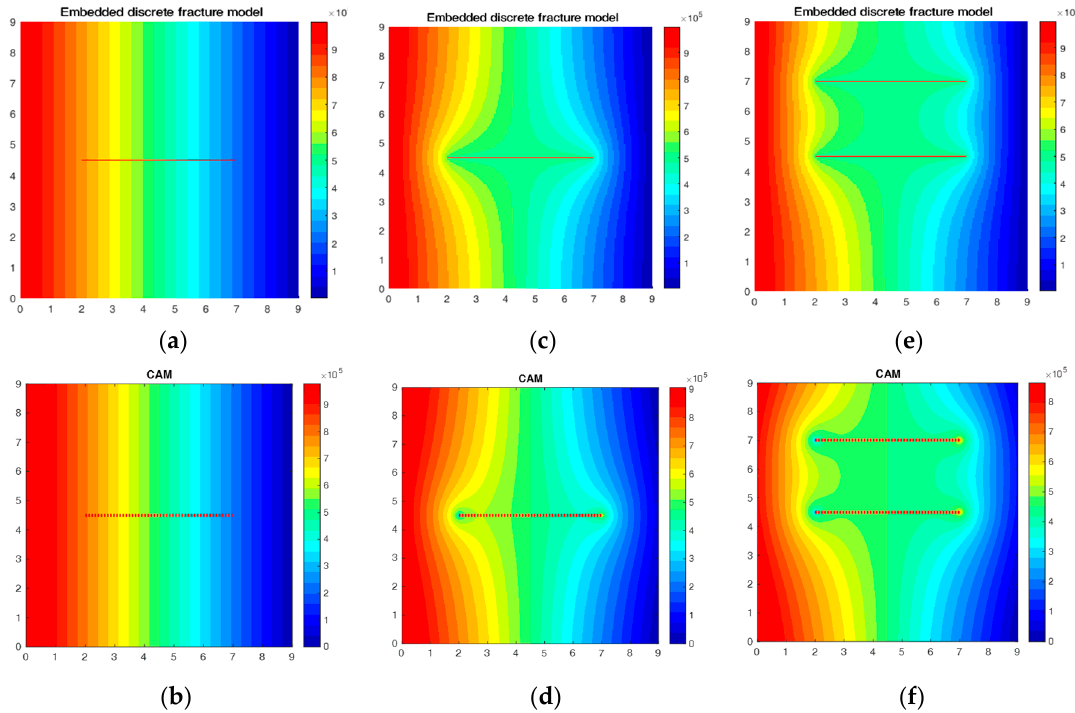
Figure 10. Pressure field solutions (scaled in Pa) around a non active fracture ( a , b ), active single fracture ( c , d ), and a pair of horizontal fractures ( e , f ). The reservoir space assumes a single phase 2D flow with the following boundary conditions and fluid properties: P right = 0 Pa, P left = 10 Pa, fluid viscosity is 0.1 Pa s (1 cP) and fluid density is 1 g / cm 3 . ( a , c , and e ; Top row): Grid-based solutions using an embedded discrete fracture model (EDFM). ( b , d , and f ; Bottom row): Grid-less CAM solution of the same pressure field.